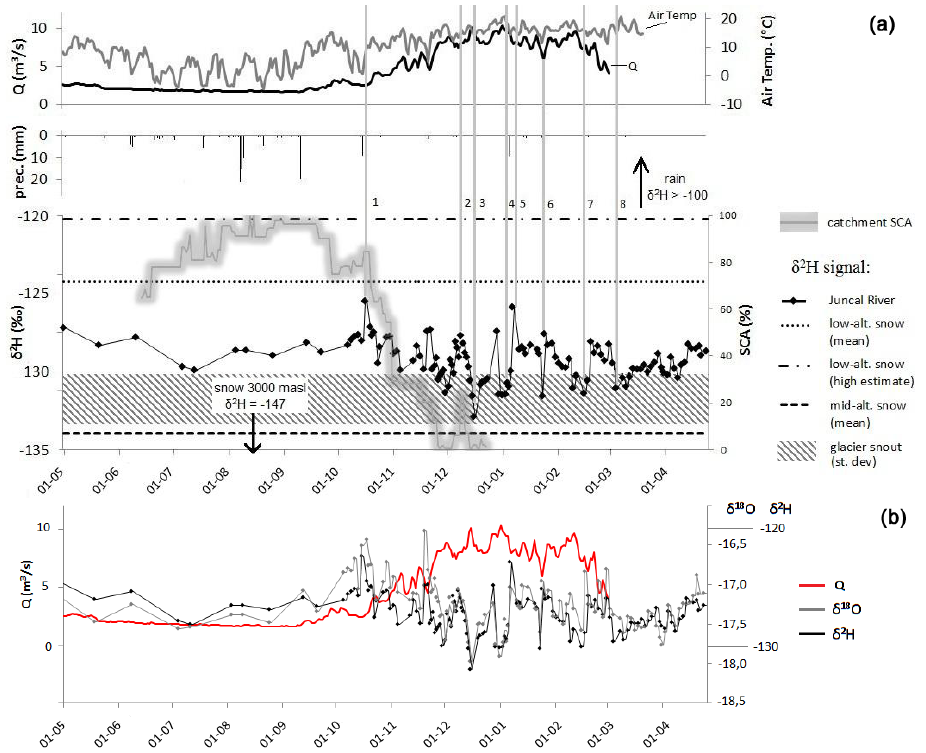
Fig. 9. (a) Temporal variation in δ 2 H in the Juncal River during the study period (May 2012–April 2012), with average values for low- (2200–2600) and mid- (2600–300) altitude snow and standard deviation of glacier melt. The figure also shows catchment SCA and discharge, precipitation and air temperature at Hort. (b) Temporal variation in δ 2 H and δ 18 O during the study period, along with discharge in the Juncal River.